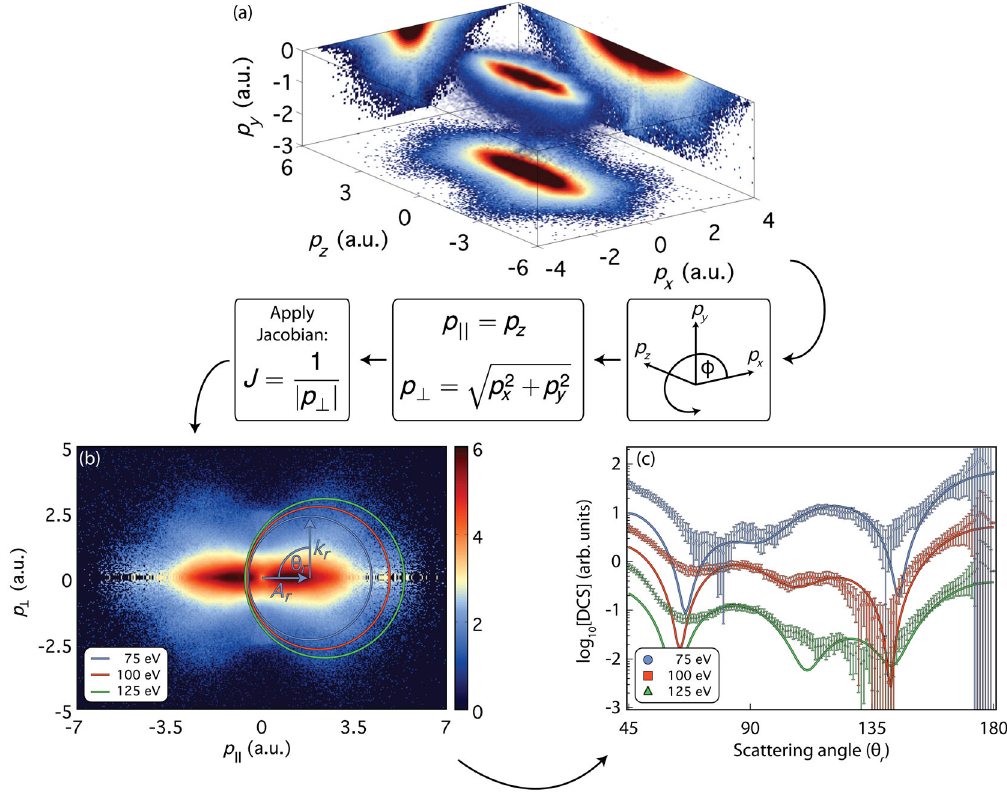
FIG. 11. The extraction of elastic DCSs of electrons scattering off Xe atoms using the LIED technique. (a) Xe is ionized by the 3 . 1 - μ m radiation with an intensity of ≈ 6 × 10 13 W cm − 2 and the full 3D momentum distribution is detected by the ReMi. (b) After integration around the azimuthal angle ( ϕ ) and the application of the appropriate coordinate transformation Jacobian, a 2D representation of the momentum distribution is achieved. (c) The DCSs are found by tracing the radius (corresponding to the return electron momentum k r ) of a circle that has been shifted by the vector potential A r at the time of electron rescattering. Accurate DCSs are presented for return energies E r of 75 eV (blue circles), 100 eV (red squares), and 125 eV (green triangles) over a wide scattering angle range. The solid lines are taken from the NIST database